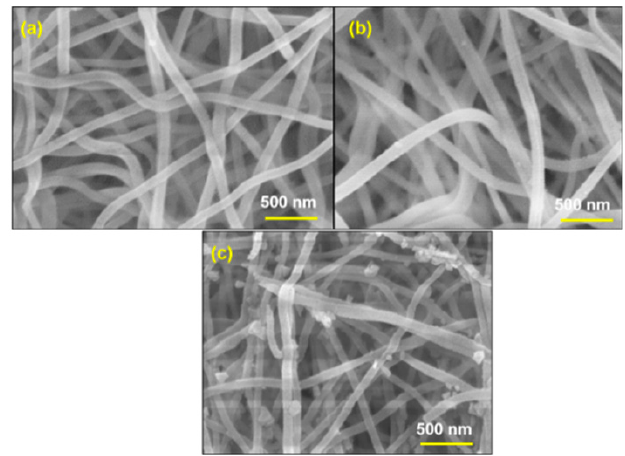
Figure 8. SEM images of Al 2 O 3 -CuCrO 2 nanofibers annealed at 600 °C for ( a ) 30 min, ( b ) 60 min, and at 700 °C for ( c ) 30 min.